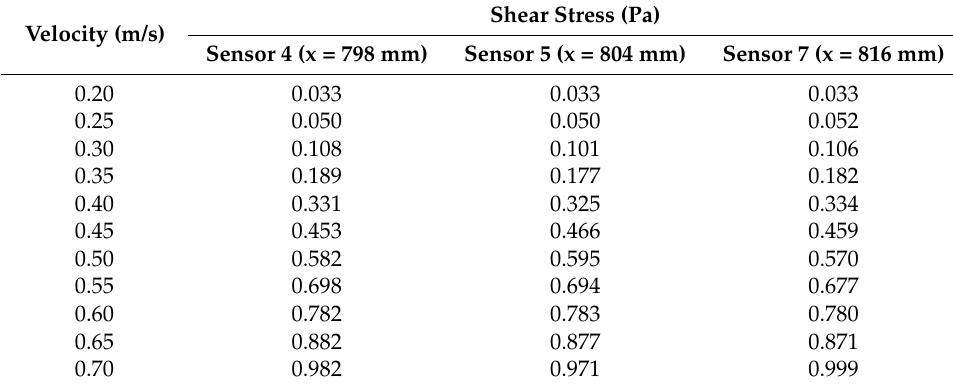
Table 1. Shear stress measured by hot-film